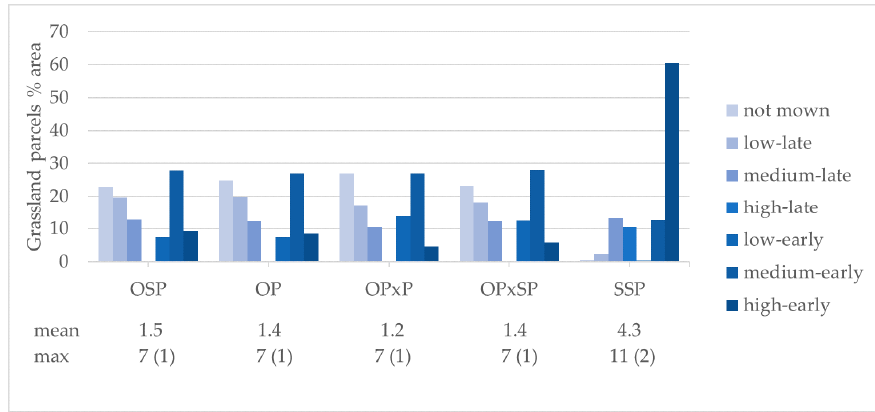
Figure 9. Percentage of grassland parcel area derived from various spatial mapping units and clouds masking levels within GMI categories, and number of detected mowing events: mean and maximum (frequency). Optimized-pixel—aggregated to parcel (OPxP); Optimized-pixel—aggregated to shrunken parcel (OPxSP).